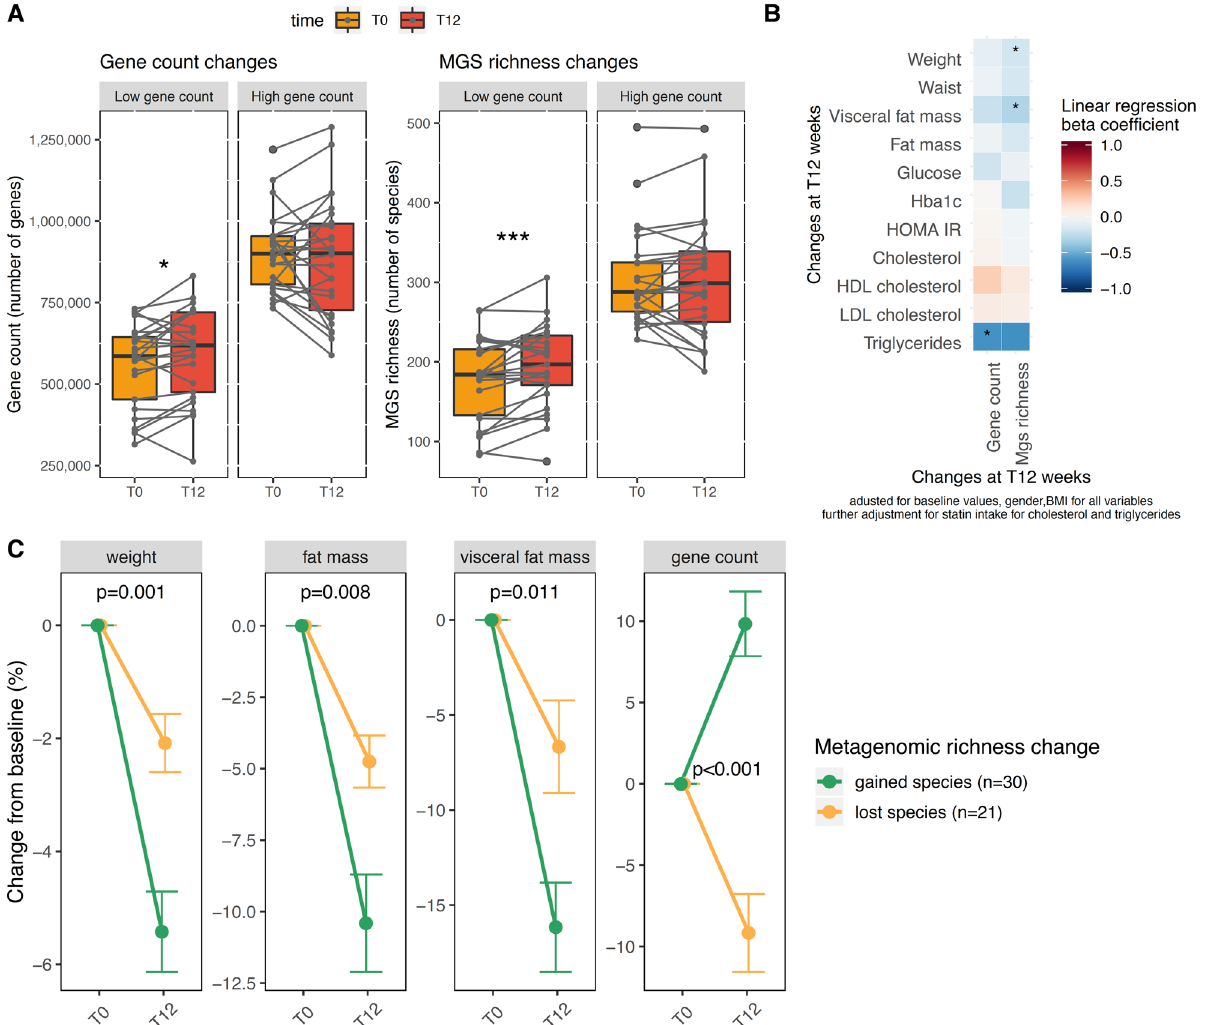
Figure 2. Evolution of metagenomic richness 12 weeks after dietary intervention. ( A ) Evolution of gene count (number of genes) and metagenomic richness (number of MGS) depending on baseline gene richness status The fixed effect of time (the intervention) was analysed in a mixed linear model with patients as random effects. * p < 0.05, ** p < 0.001. ( B ) Evolution of richness associations with the clinical evolution. Heatmap of standardized beta coefficient from linear regression. Model is adjusted for baseline values + baseline BMI and sex. For cholesterol and triglycerides, the model is also adjusted for baseline statin intake. ( C ) Evolution of weight, fat mass, visceral fat mass and gene count depending on richness response. Change from baseline is (T12–T0/) T0 * 100. Gained species are individuals who increased their MGS richness. Lost species are individuals who decreased their metagenomic (MGS) richness. P values of the effect of MGS richness change in a linear regression model adjusted for baseline value, sex and BMI. Points are mean, bars are SEM. Figure conceived using R version 3.3.2, R Core Team (2019), https:// www.R- proje ct.